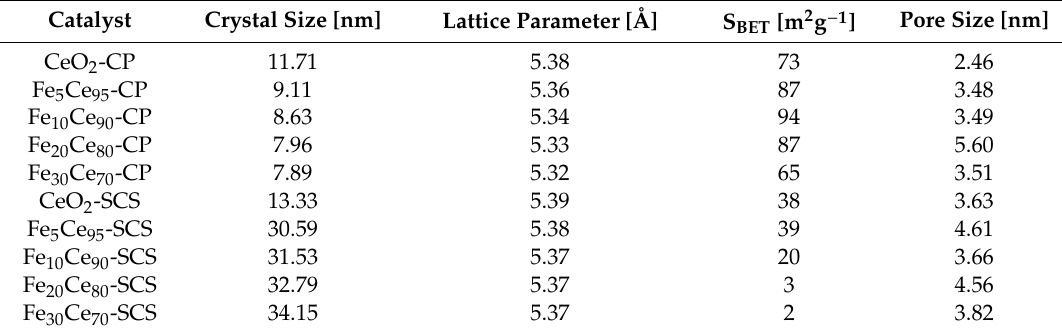
Table 1. Textural properties of as-derived